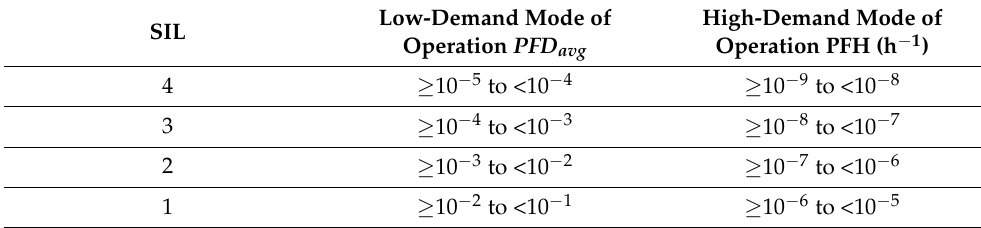
Table 8. SIL and the corresponding PFD and PFH targets.